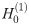
Statistical hypothesis testing indicates dissociation of Bmal1-ELuc and Per1-luc rhythms at the single cell level.A) Gaussian kernel density estimates in the bivariate graph of Bmal1 and Per1 oscillation periods, estimated by a Lomb Scargle analysis of surrogate time lapse movies, generated under hypothesis H0(1), i.e., dynamical dissociation at the single cell level. B) Same as panel (A) in case of hypothesis H0(2), i.e., randomly located cells with either Bmal1 or Per1 signal of different periods. In both panels, N = 150 cells have been randomly drawn. Signal intensities of 1, Bmal1 period of 23h, Per1 period of 24h, cell sizes σG = 0.0132 and noise strength of σn = 1 were used. See S1 Fig for an example. C) Top: Average values (bold line) and standard deviations (shaded areas) of Per1-luc (blue) and Bmal1-ELuc (orange) signals from a cultured SCN of double transgenic mice. Bottom: Times of oscillation peaks (acrophases) in the averaged Per1-luc (blue) and Bmal1-ELuc (orange) signals. Compared to Per1-luc signals, phase drift of Bmal1-ELuc in oscillation peak times can be observed, suggesting a shorter Bmal1-ELuc period. D) Histograms of pixel-wise oscillation periods in the Per1-luc (blue) and Bmal1-ELuc (orange) signals as determined by a Lomb Scargle periodogram analysis. Bold lines denote fits of a (non-central) Student’s t-distribution to the histogram data. The Student’s t-distribution has been preferred over normal distribution for its lower sensitivity to outliers [26]. Fitted parameters for the location (similar to the mean of a Gaussian) and scale parameter (similar to the standard deviation of a Gaussian) are ≈ 23.87 ± 0.06 h and ≈ 23.40 ± 0.13 h in case of Per1-luc and Bmal1-Eluc signals, respectively. E) Pixel-wise comparison of Per1-luc and Bmal1-Eluc periods as shown by a scatter plot (crosses) together with the corresponding kernel density estimates. The broader distribution of Bmal1-ELuc periods can be due to the lower SNR (signal-to-noise ratio) in comparison to the Per1-luc signal. Data analyzed in panels (C)-(E) correspond to the ones shown in Figure 5 of reference [21].